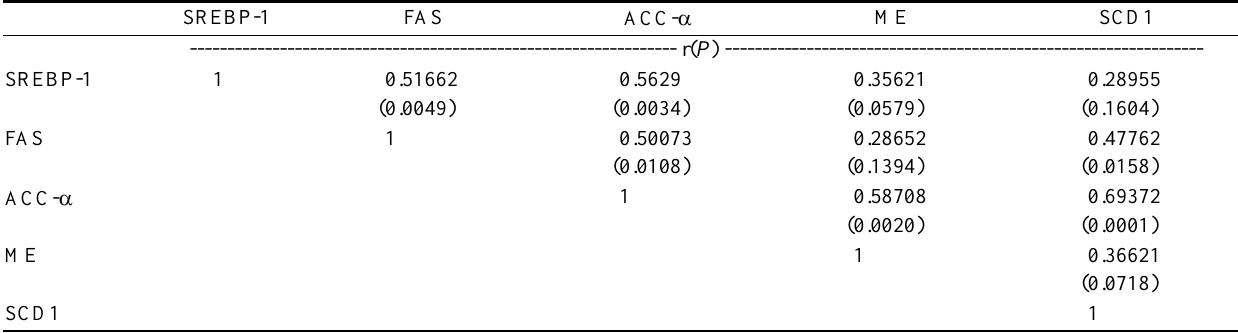
Pearson’s correlation coefficients (r) are shown with p values in parentheses. Table 4. Correlations between expressions of hepatic genes related to lipid synthesis and transporting to egg yolk